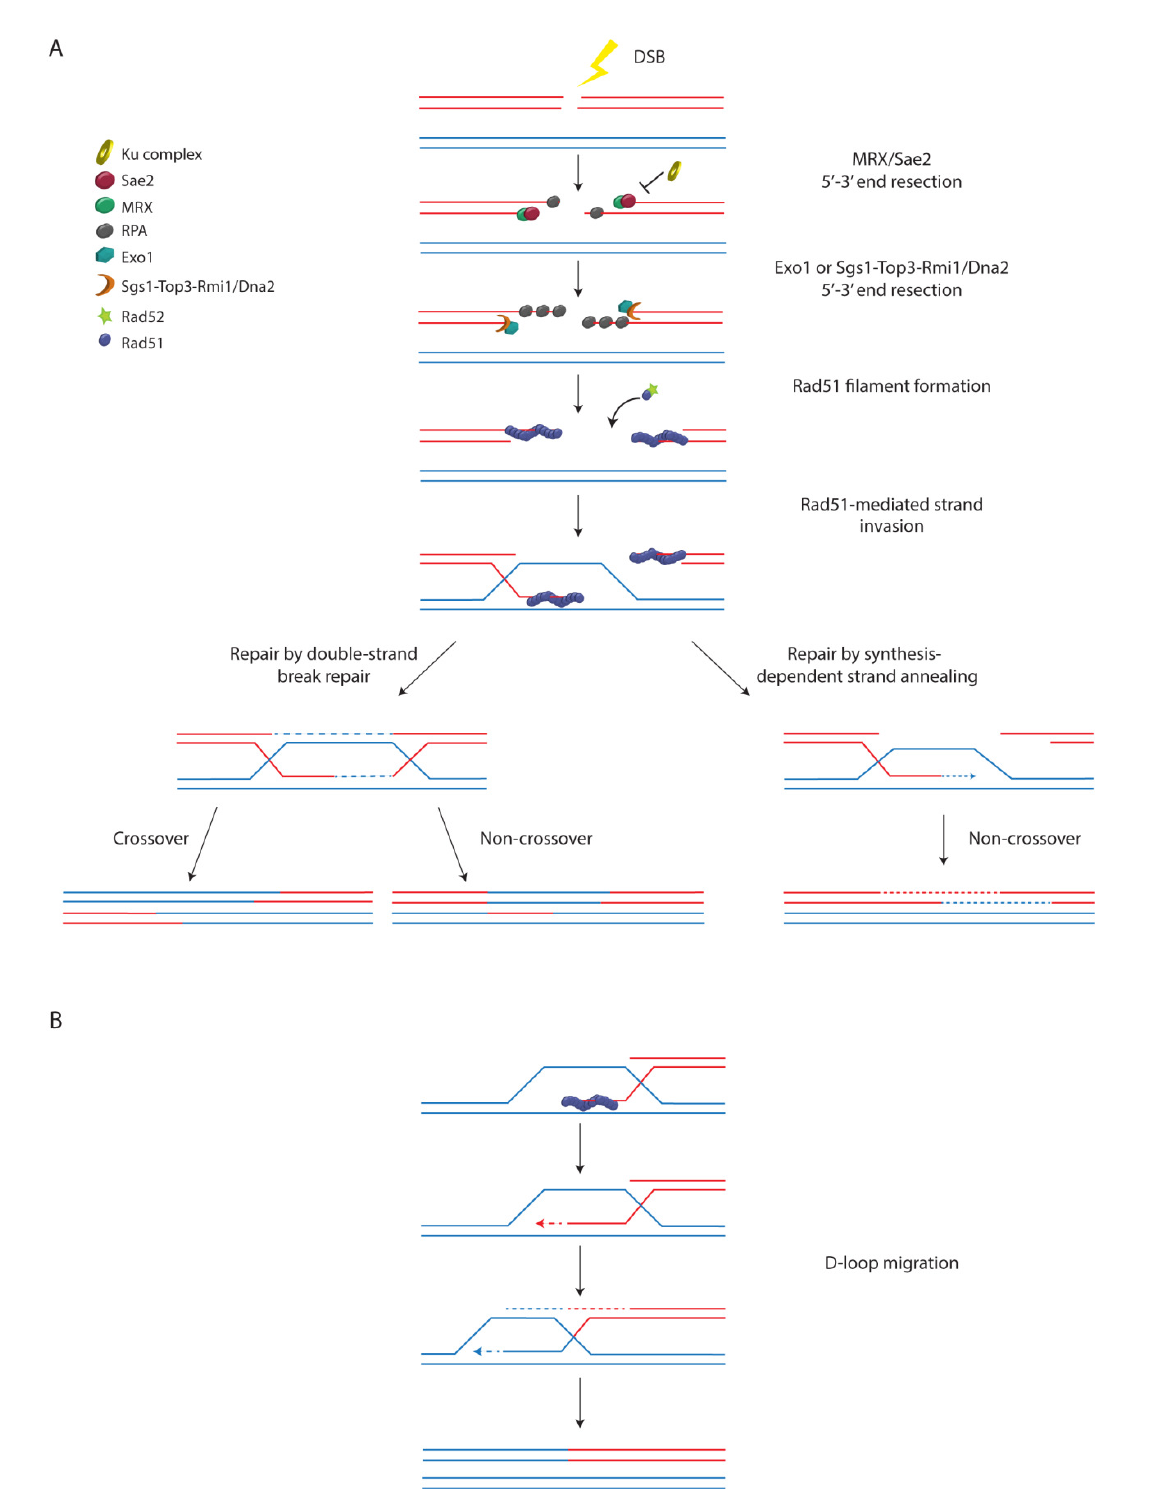
OPEN ACCESS | www.microbialcell.com